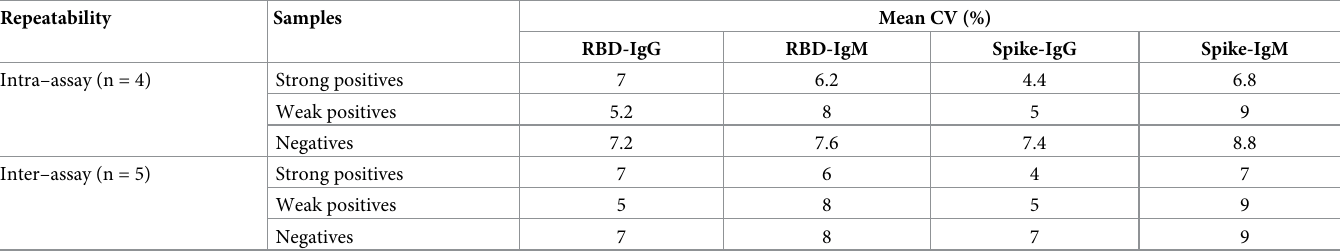
Table 4. Repeatability of the described ELISAs, based on calculated intra- and inter-assay coefficients of